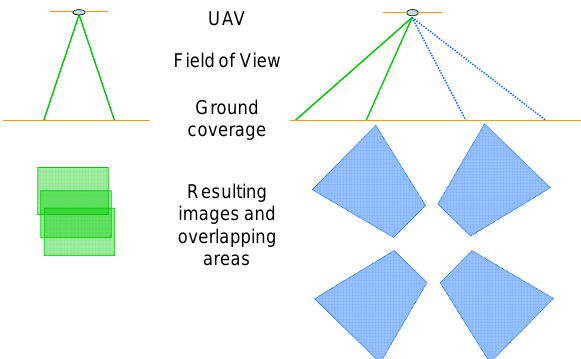
Figure 1: Ground coverage of an oblique "Four Vision" System compared to conventional nadir looking